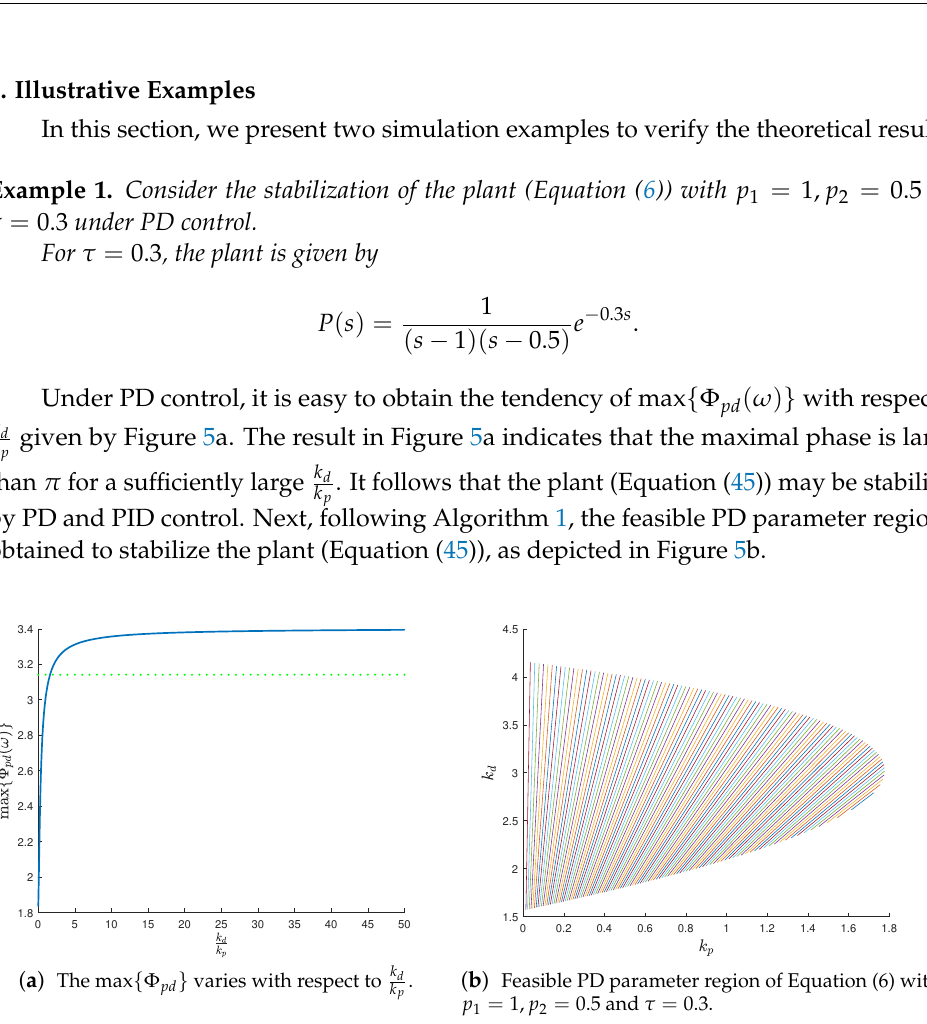
Figure 5. Stabilization under PD control. The first figure indicates that the maximal phase is larger